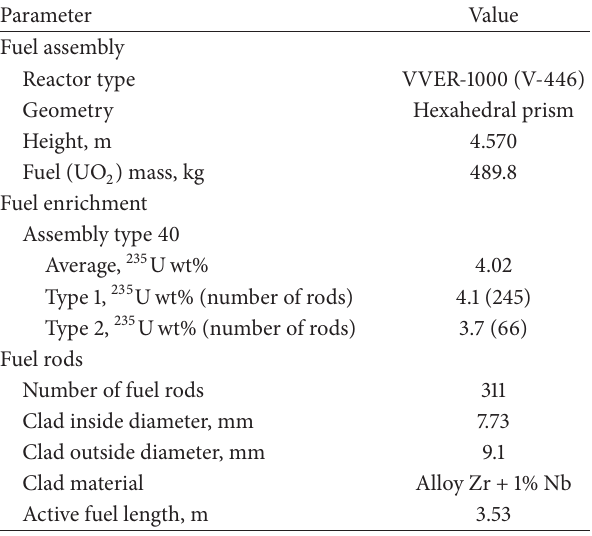
Table 1: Main characteristics of the FAs used in BNPP. Table 2: The result of benchmark calculations of VVER-1000 SFA (60 GWd/MTHM and 3-year cooling